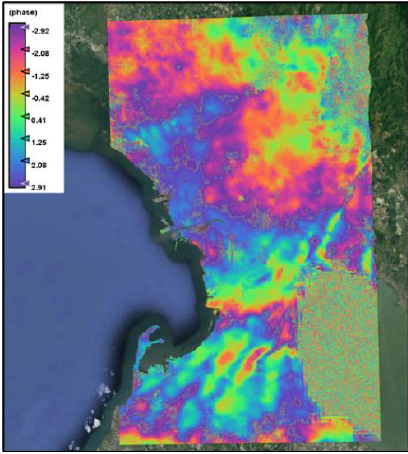
Figure 9. Terrain Corrected Interferogram